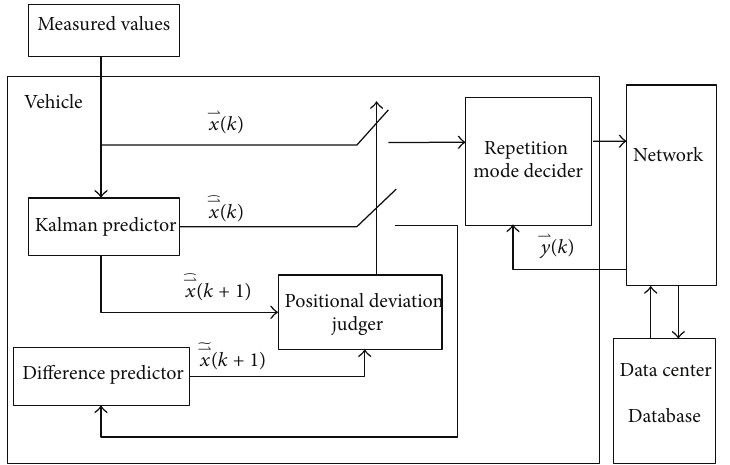
Figure 3: The vehicle position updating model with packet